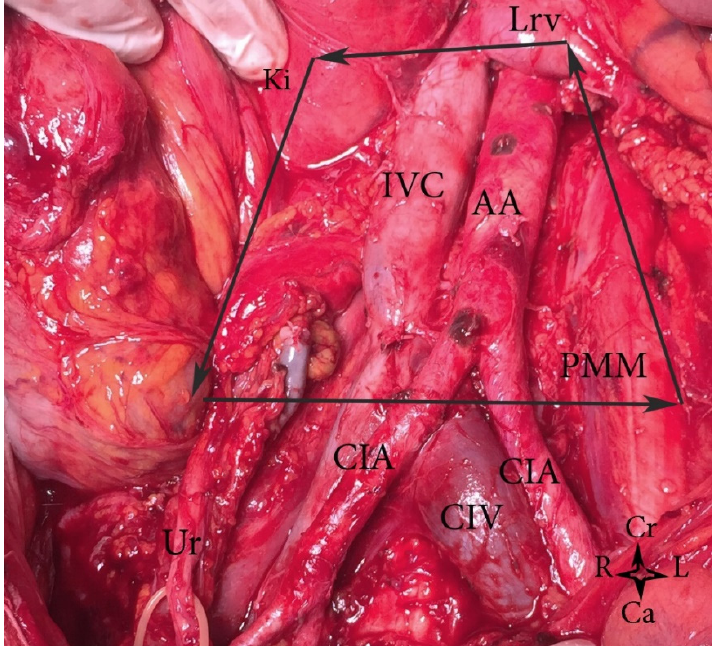
Figure 5. Boundaries of PALND (open surgery). AA—abdominal aorta, IVC—inferior vena cava, CIA—common iliac artery, CIV—common iliac vein, Ur—ureter, Ki—kidney, Lrv—left renal vein, PMM—psoas major muscle, Cr—cranial, Ca—caudal, L—left, R—right.